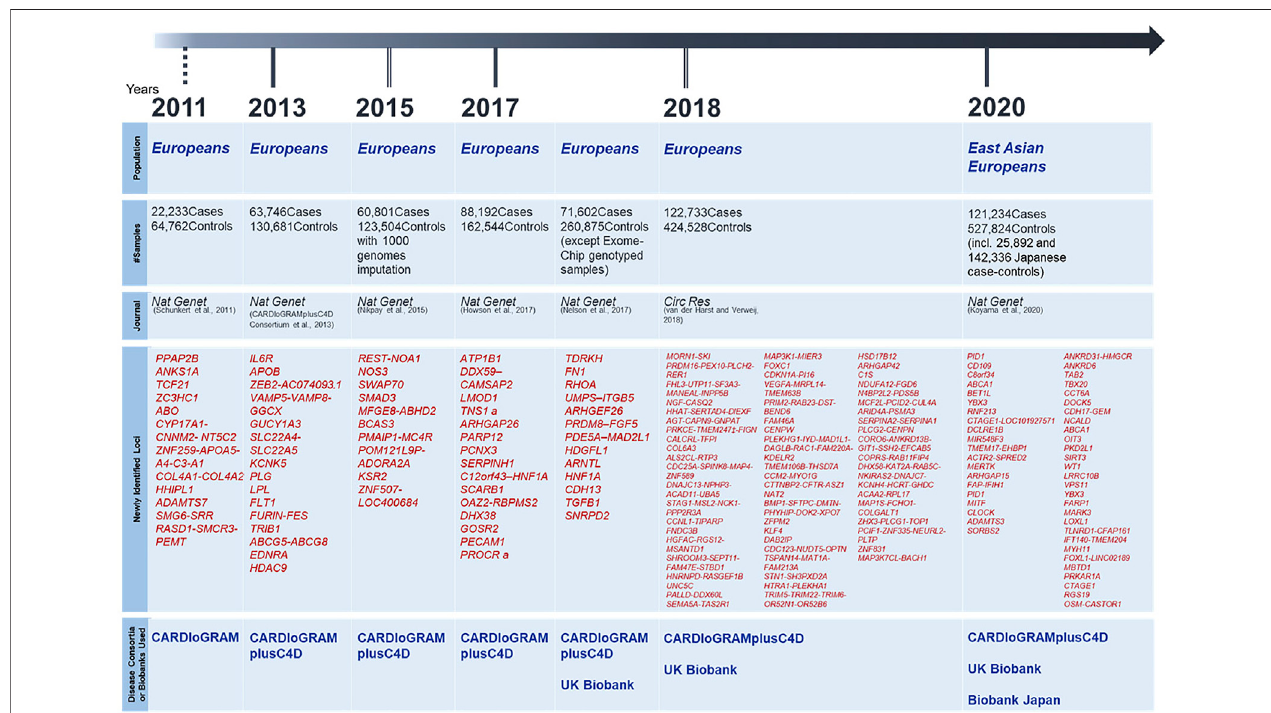
FIGURE 1 | Landmark papers of CAD-GWAS and Newly Identi fi ed Disease Susceptibility Loci Since 2010.